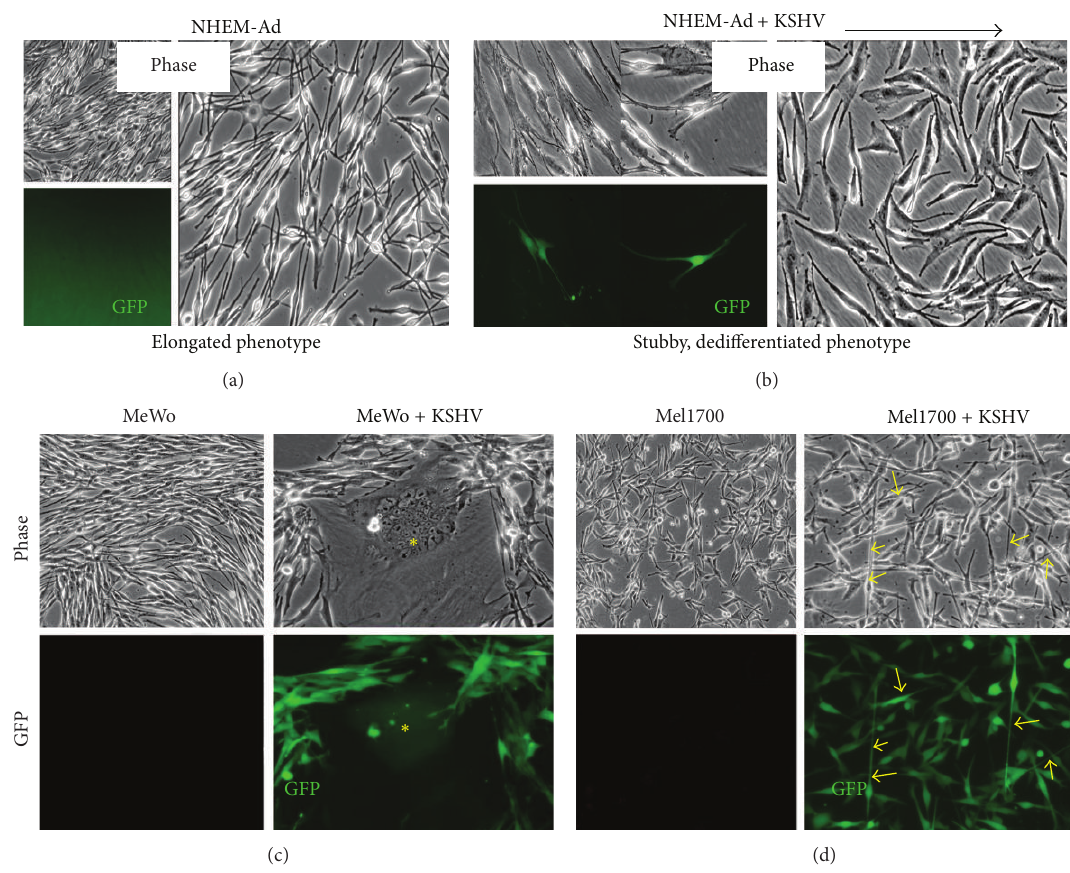
Figure 1: KSHV infection of primary melanocytes and melanoma-derived cells is associated with virus-induced morphological changes. (a) (b): Representative phase and GFP images of uninfected (a) or rKSHV.219-infected (b) primary NHEM-Ad melanocytes at day two after infection. Rightmost panels are enlarged (20x) phase contrast views of uninfected and infected cultures, respectively. (c) (d): Representative images of uninfected or rKSHV.219-infected MeWo cells (c) and Mel1700 cells (d). Multinucleated cells in infected MeWo cells are denoted with asterisks, whereas yellow arrows in infected Mel1700 cells point to elongated dendritic spines putatively induced by the